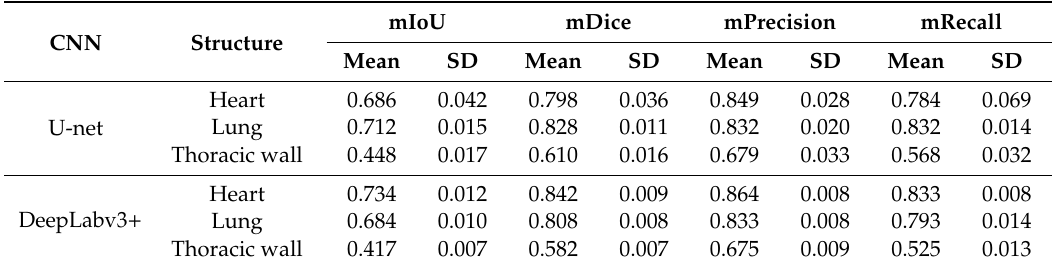
Table A1. The performance of the segmentation of the heart, lung, and thoracic wall using U-net and DeepLabv3 +